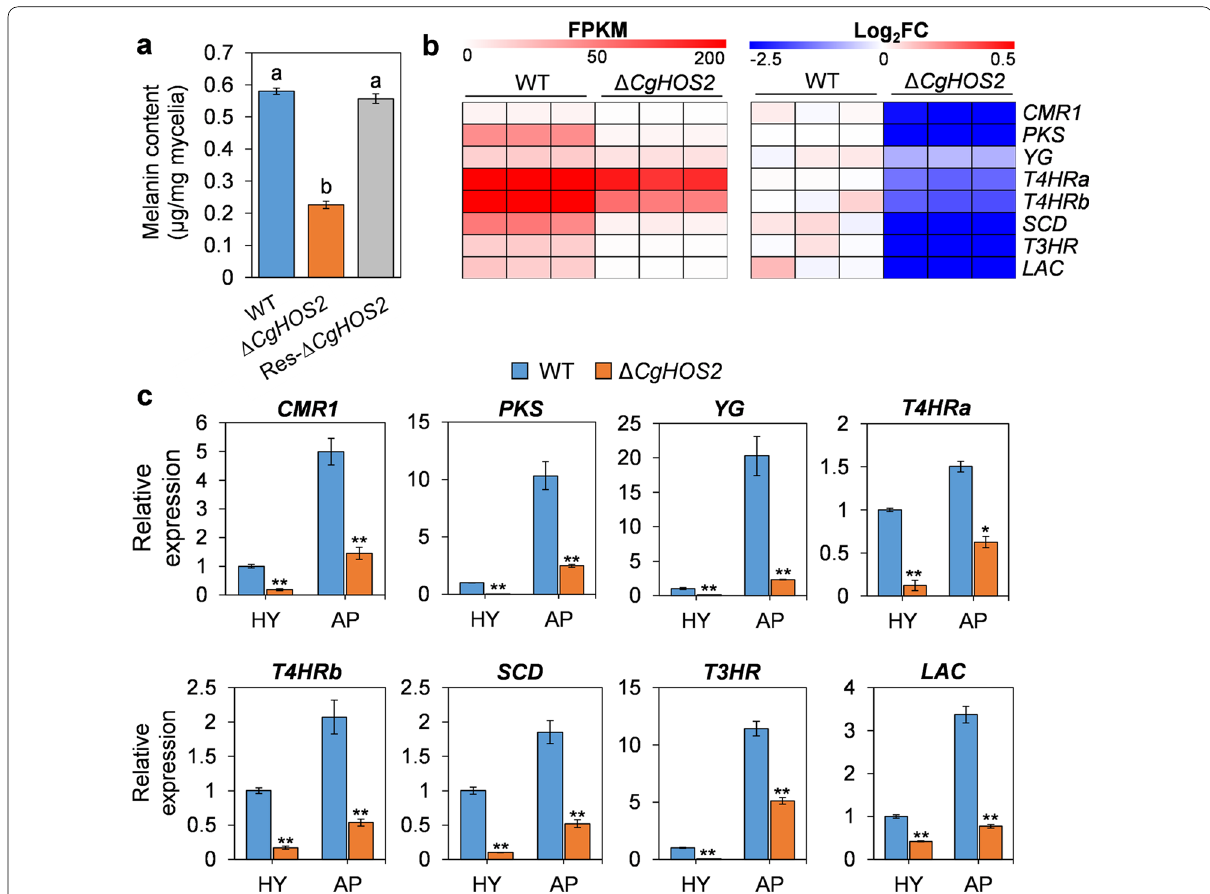
Fig. 8 CgHOS2 is required for melanin biosynthesis. a Measurement of melanin content in mycelia after incubation in potato broth for 3 days. b Relative transcript levels of 7 melanin biosynthesis-related enzymes and the transcription factor CMR1. The transcripts were expressed as FPKM values based on the transcriptomic data. FPKM 2 normalized values were used to calculate the fold change (FC), and the relative levels were + expressed as log 2 FC values. c Relative expression levels of the genes based on the RT-qPCR data; β2-tubulin was used as an endogenous control for normalization. The values are shown as the means standard deviations (SD). The columns with different letters indicate significant differences ± ( P < 0.05), and the asterisks indicate significant differences at P < 0.05 (*) and P < 0.01